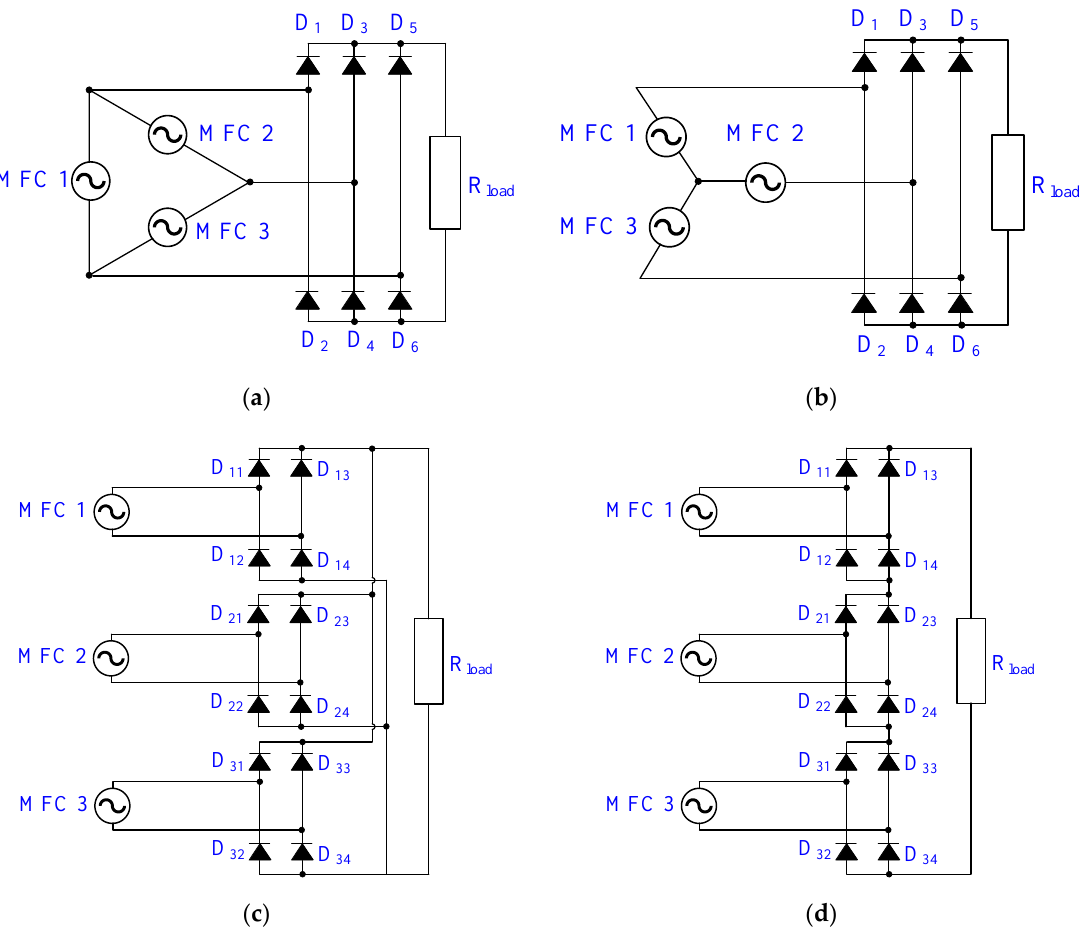
Figure 4. Arrays of three MFC patches: ( a ) delta circuit; ( b ) star circuit; ( c ) parallel connection; ( d ) series connection.